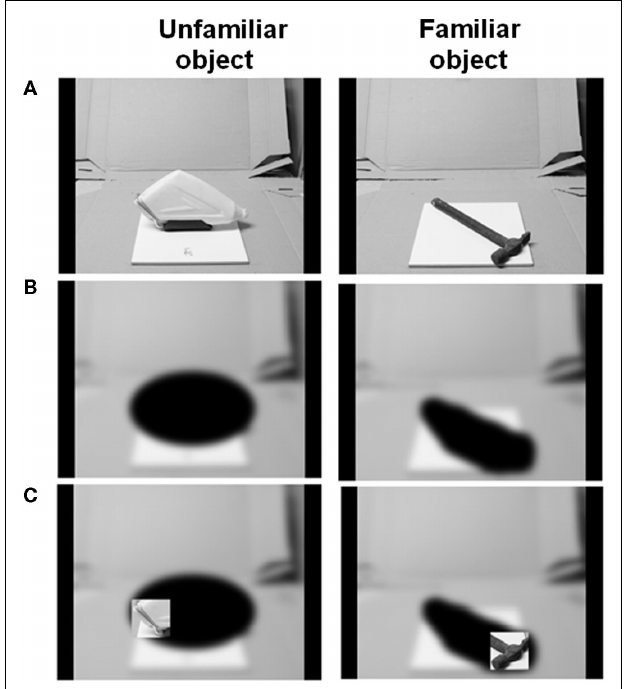
FIGURE 1 |The process of generating stimulus images for the visual object recognition task. (A) Initial photograph of object against a standard background. (B) Photograph is blurred and the object occluded with black ellipses. (C) A square aperture revealing original photograph (no blur or occlusion) is guided across the image by the participant’s finger movements.